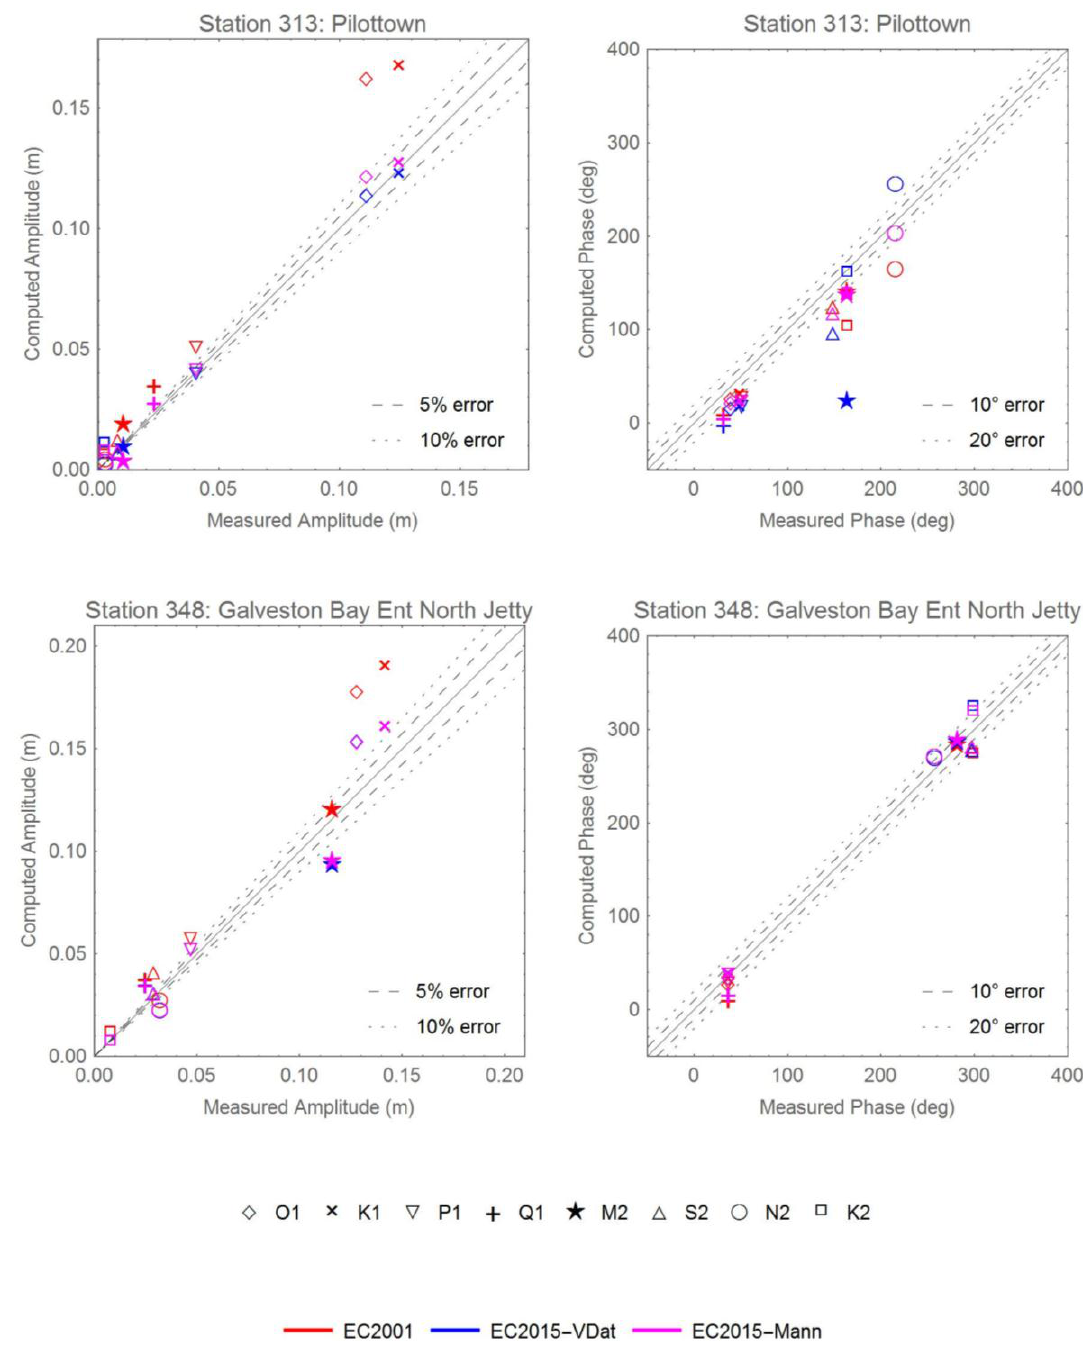
Figure B3. Scatterplots of computed versus measured harmonic data for representative stations along the Gulf of Mexico coast.